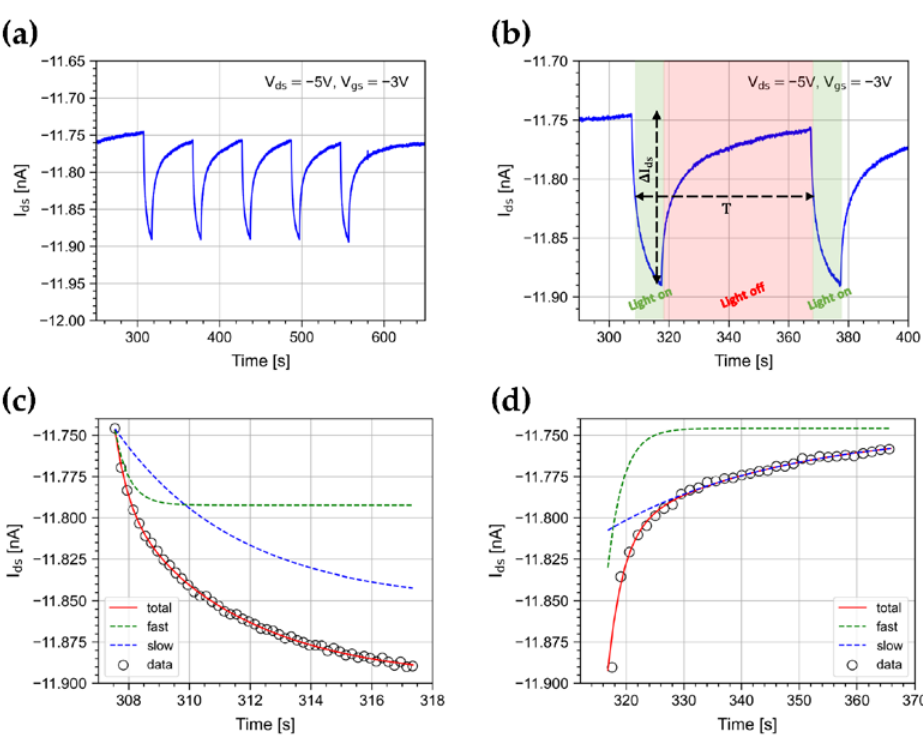
Figure 3. ( a ) I ds current when illuminating the device with a 5-pulse burst with a period of T = 60 s. ( b ) Details of the first two pulses of the burst. Data and best-fit curve with details on the fast and slow exponential function components for the ( c ) signal growth and ( d ) decay.